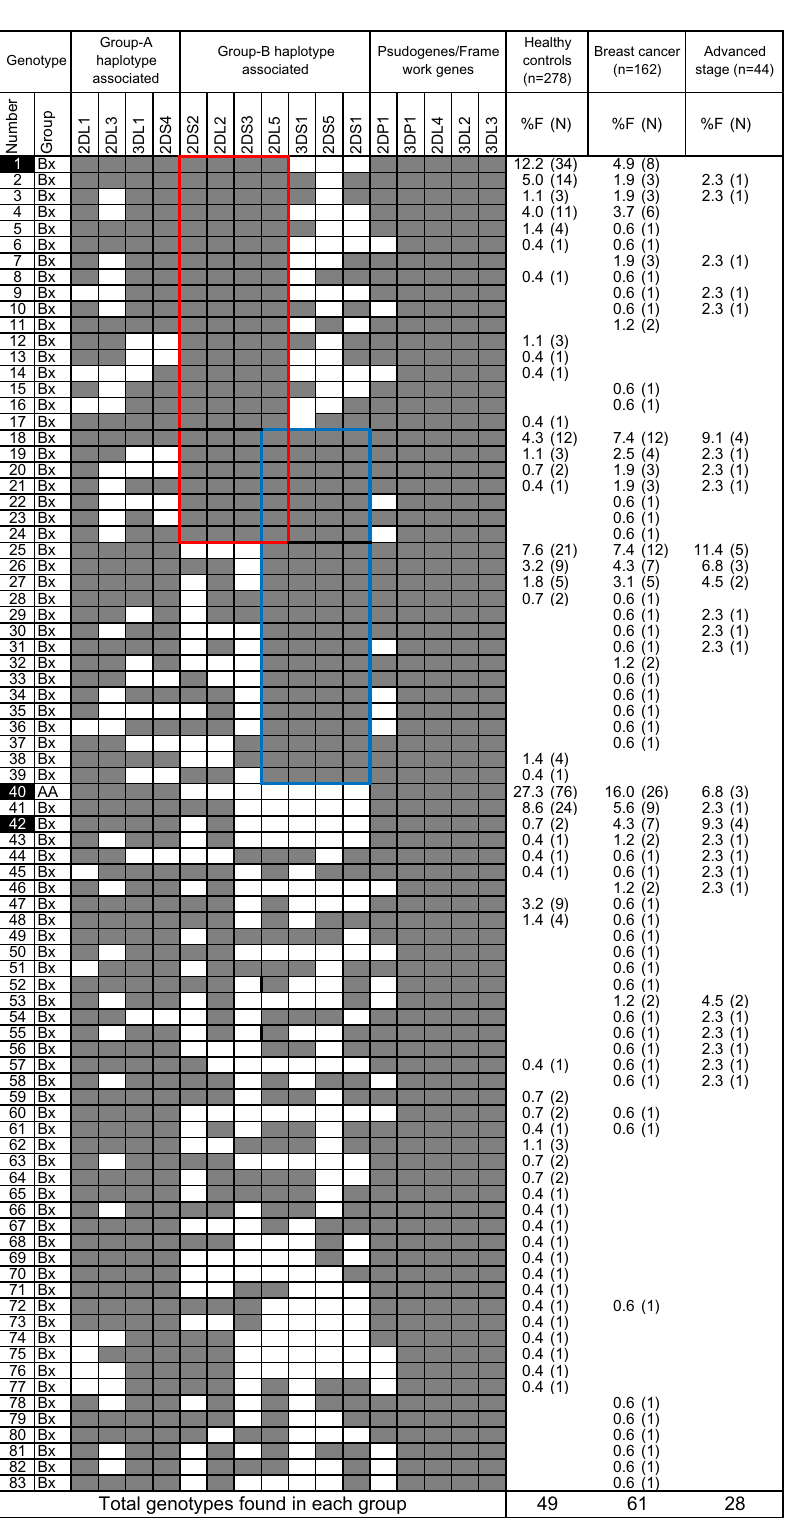
Figure 2. KIR gene content diversity in patients with breast cancer. Eighty-three distinct KIR genotypes were observed that differ from each other by the presence (shaded box) or absence (white box) of 16 KIR genes. The frequency (%F) of each genotype is expressed as a percentage and defined as the number of individuals having that specific genotype (N) divided by the number of individuals studied (n) in each group. The frequency of genotypes # 1, #40, and #42 was significantly different between patients and controls and are marked by dark boxes. The C4 and T4 linkage groups are marked by red and blue boxes,